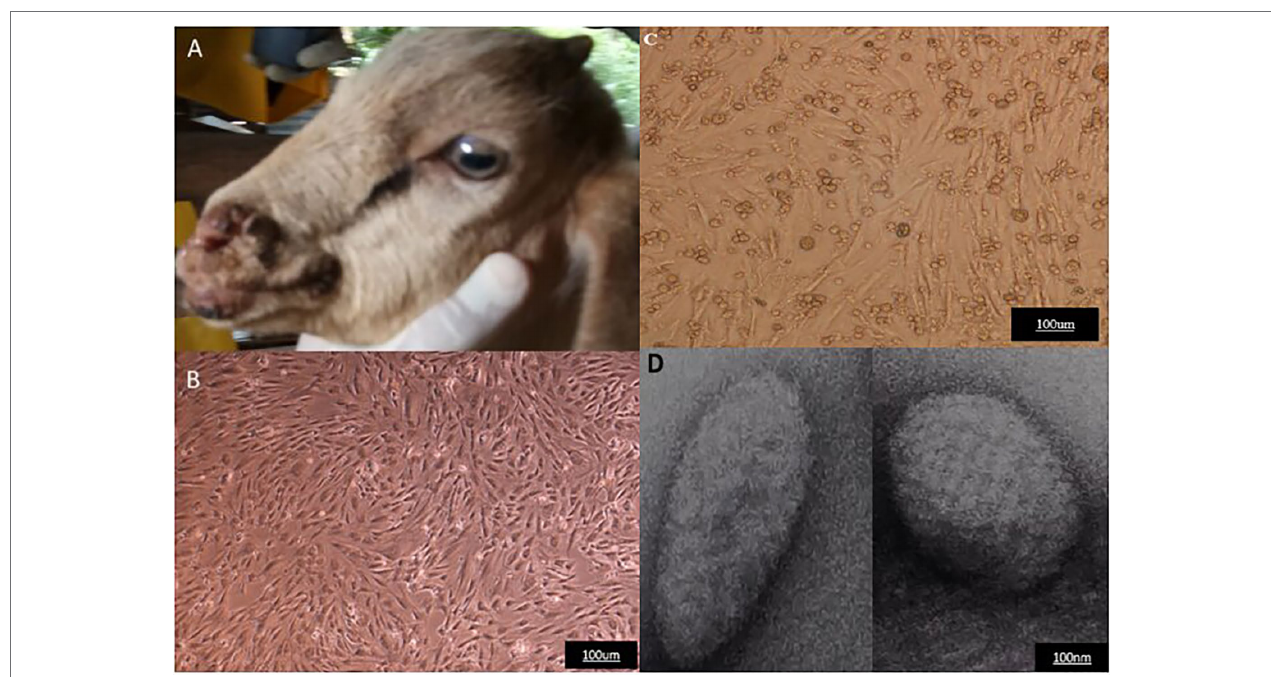
FIGURE 1 | Representative of clinical case of Orf virus (ORFV) infection, Cytopathic effect following ORFV infection of LT cells, and electron microscopy of the purified virus. (A) Goat showing multiple lesions. (B) Uninoculated LT cells. (C) Infected cells with cytopathic effect post-inoculation. (D) Electron micrograph of the purified